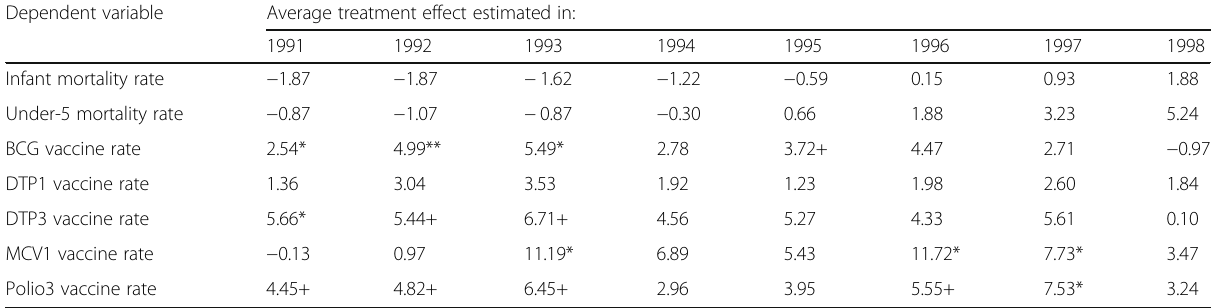
Table 5 Synthetic control estimates of average treatment effect of CRC adoption on child mortality and vaccination rates Dependent